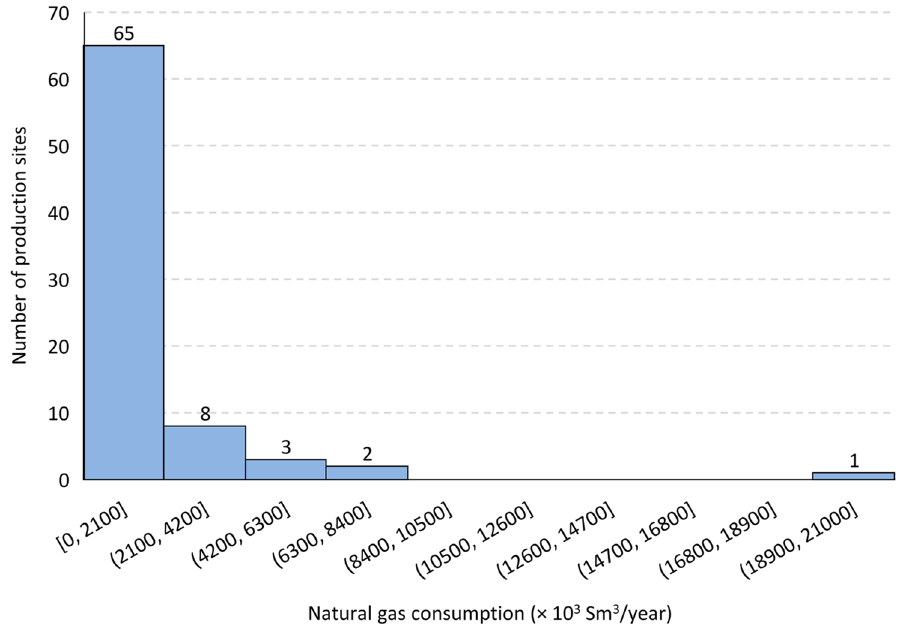
Figure 4. Distribution of yearly natural gas consumption of production sites investigated.